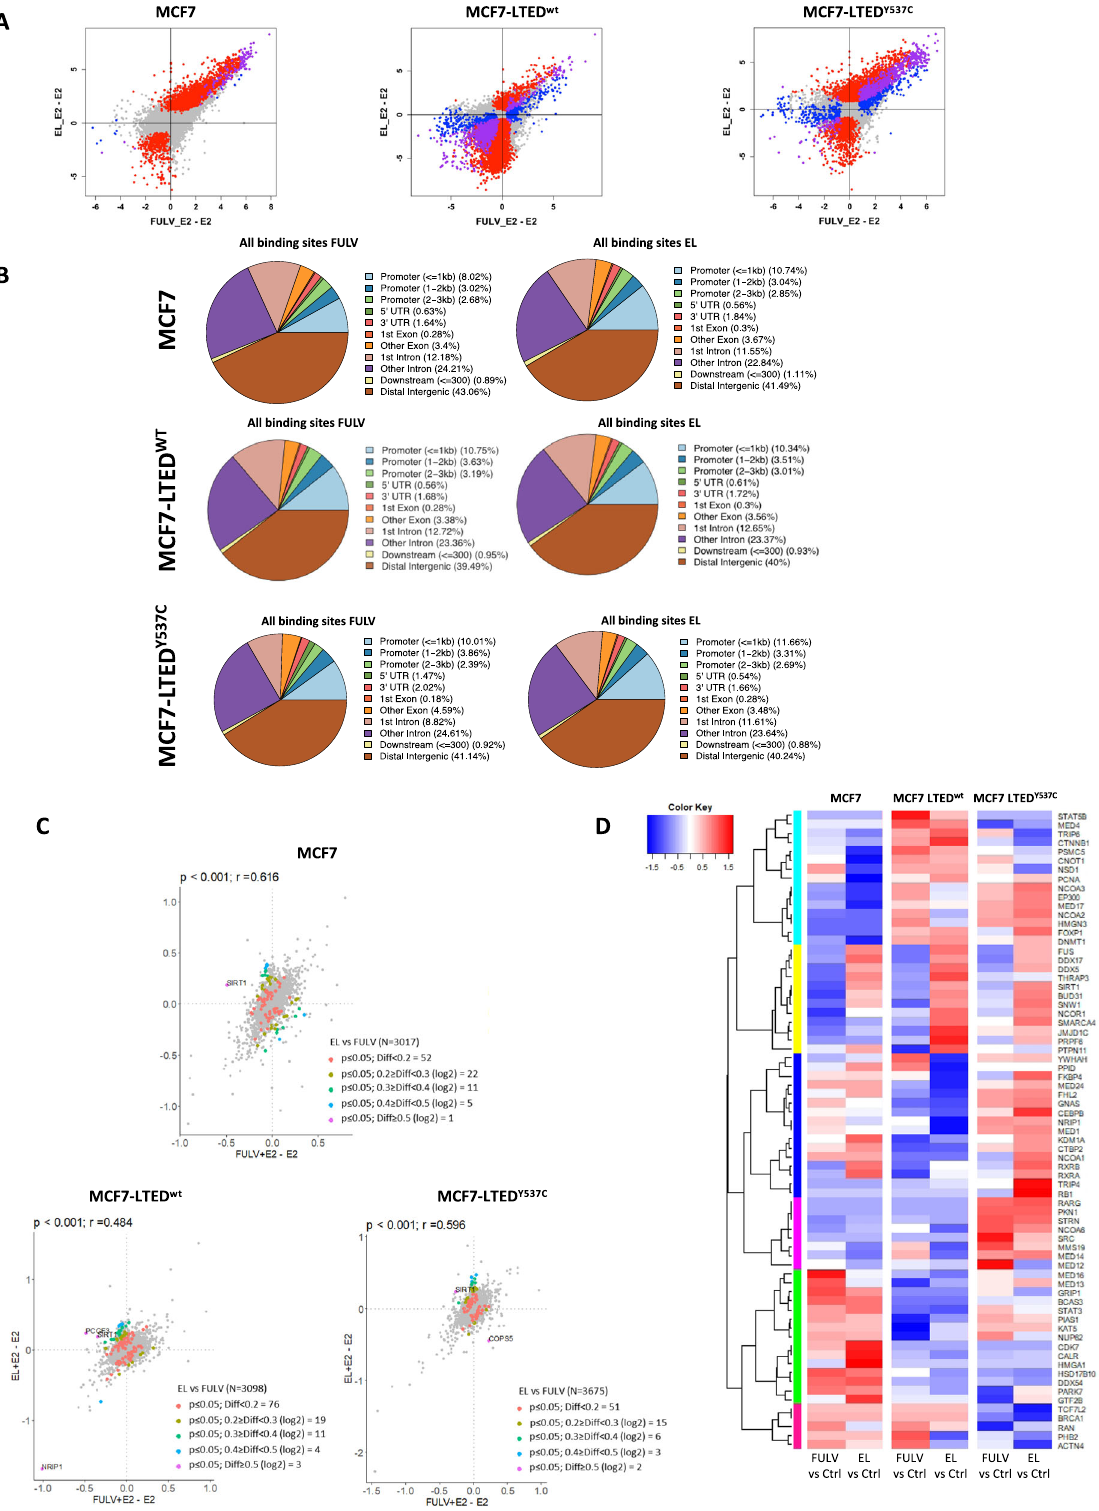
Fig. 4 Effect of fulvestrant and elacestrant on the ER-binding in MCF7, MCF7-LTED wt and MCF7-LTED Y537C . A ChIP-seq revealing similar effects of elacestrant (EL) and fulvestrant (FULV) on ER binding. Signi fi cantly differential ER binding (FDR < 0.05) as determined by DiffBind between EL + E2 and E2-only (red), between FULV + E2 and E2-only (blue) and overlap of signi fi cant binding sites (purple). B Genomic distribution of ER-binding sites. C RIME proteomics analysis revealing a similar effect of elacestrant (EL) and fulvestrant (FULV) on the ER- interactome. Different colour dots correspond to Log2 differences. D Heatmap showing GO hormone-binding proteins that interacted in cells treated with fulvestrant or elacestrant in relation to the control (E2). p value based on Student ’ s t -test or Pearson correlation is shown; r Pearson ’ s correlation score (Data from n = 2 biological replicates per treatment per cell